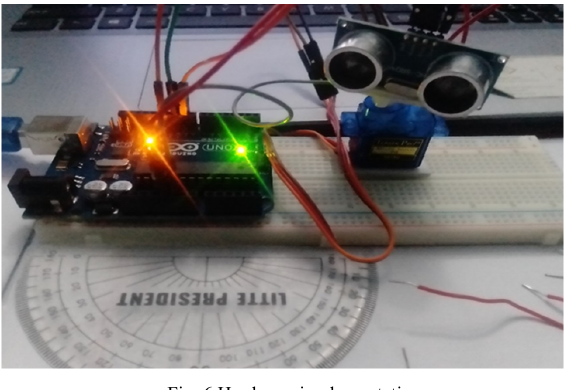
Fig. 6 Hardware implementation